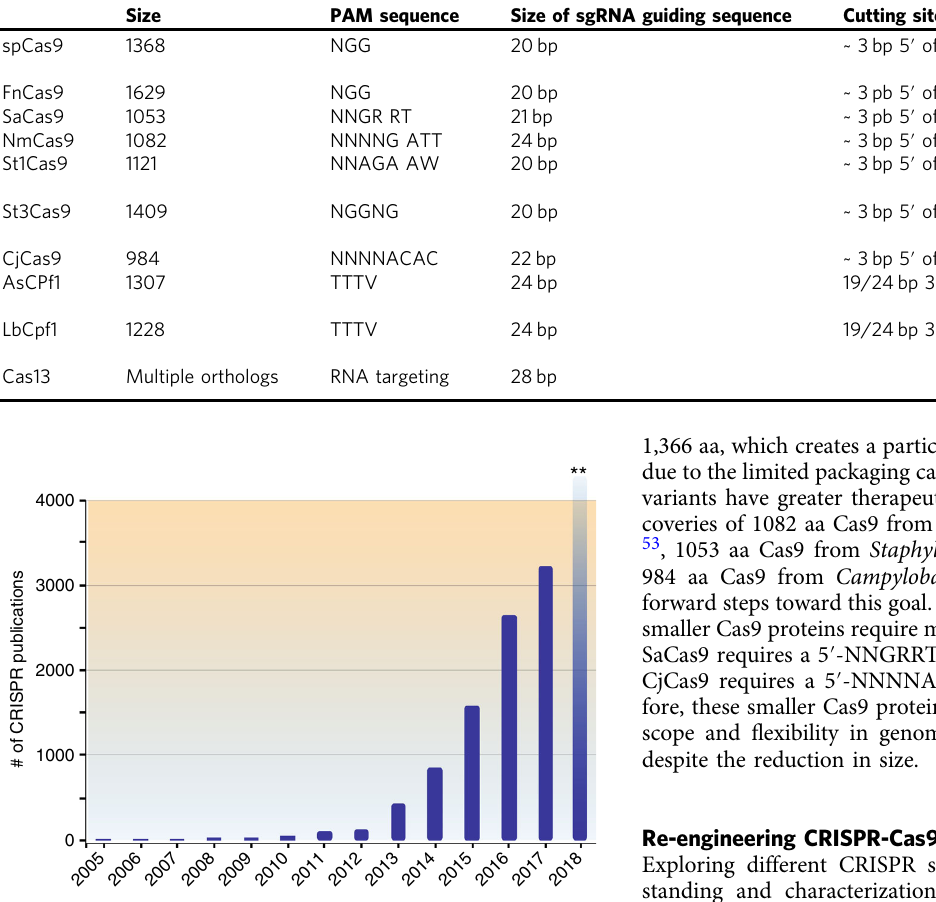
Fig. 2 CRISPR-based genome-targeting tools are widely used. Number of PubMed publications over the last 12 years that had the word “ CRISPR ” or “ Cas9 ” in the abstract or title. **Number of publications in 2018 is projected to be more than